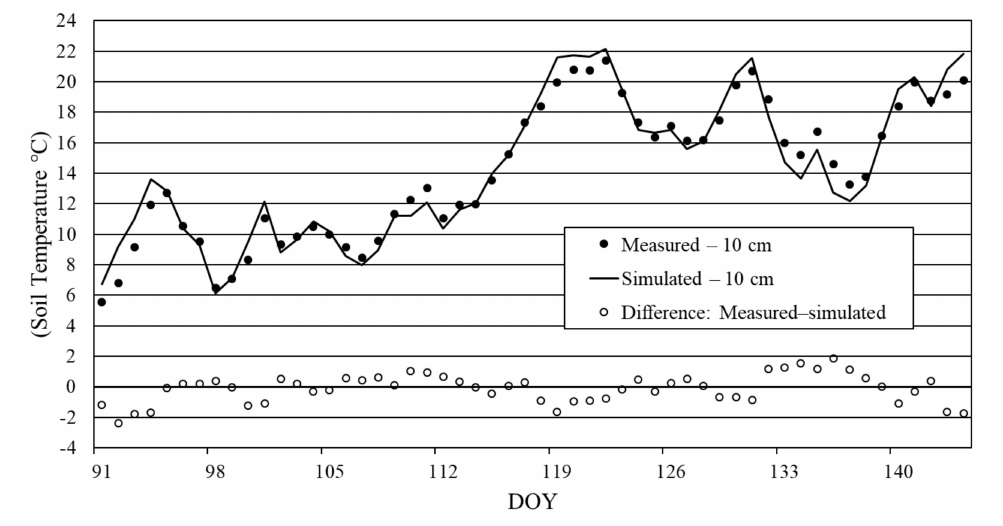
Figure 4. Measured and simulated daily mean soil temperatures at a soil depth of 10 cm in Groß-Enzersdorf (Austria) under bare soil conditions (prepared seedbed) from 1 April to 24 May 2012 (DOY = Day Of